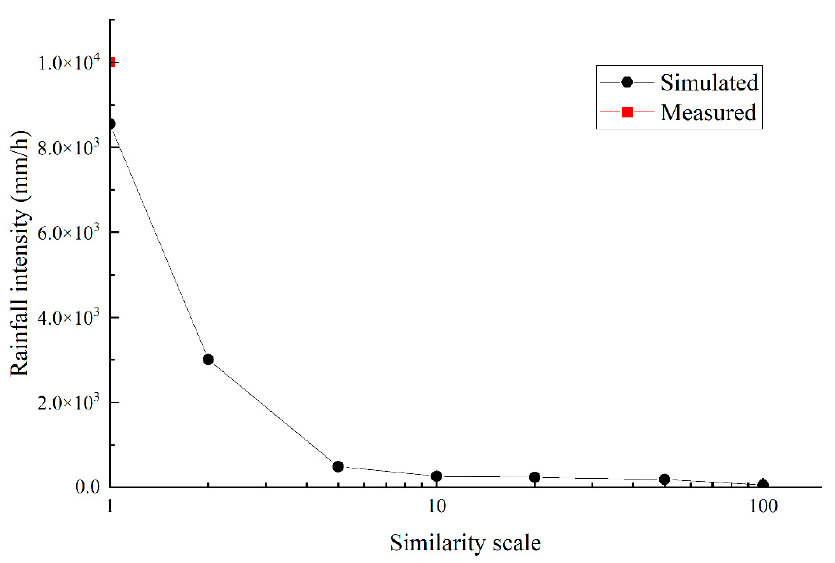
Figure 12. Intensity of atomized rain at the stable moment under different geometric scale condi- tions.